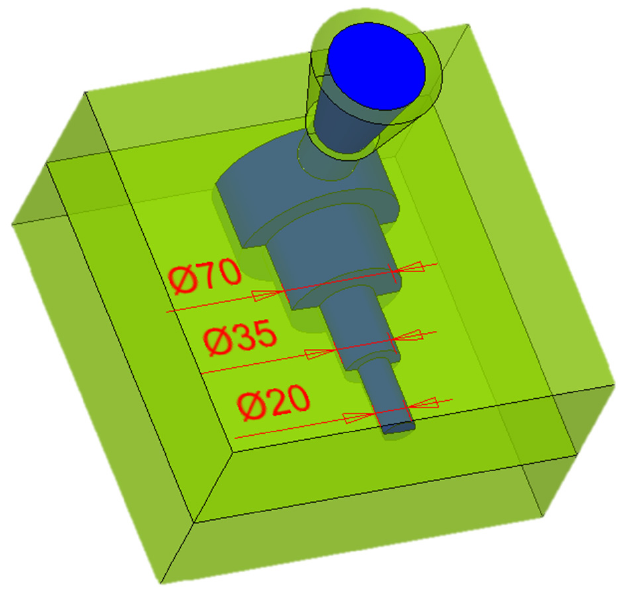
Figure 1. A 3D drawing—model of the casting.